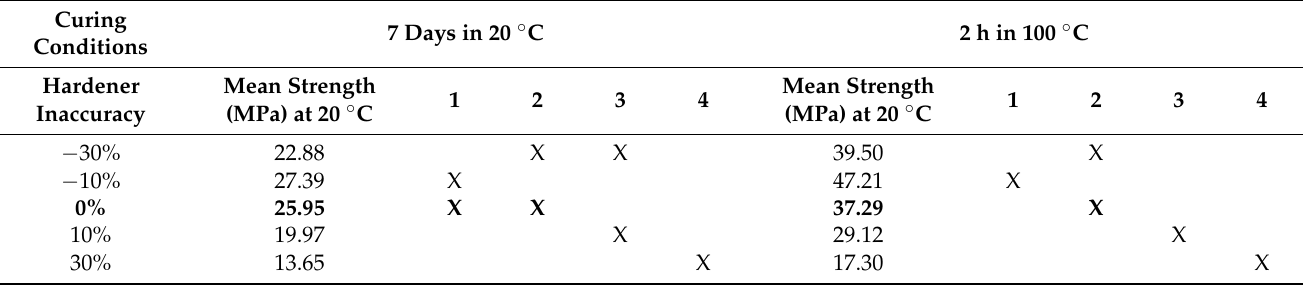
Table 3. Homogeneous groups (1-2-3-4, 1-2-3-4) of strength at 20 ◦ C for joints made with Epid- ian 57/PAC.